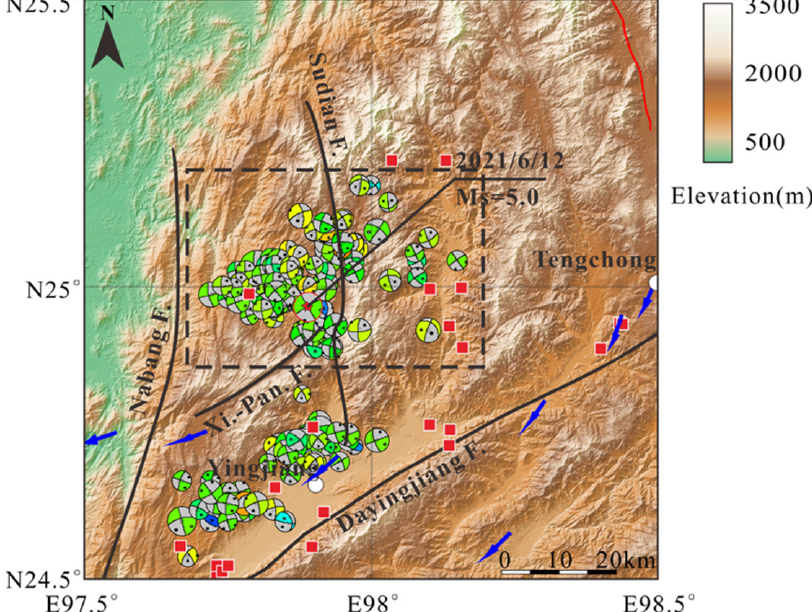
Figure 2. Distribution of the moment tensor solution used [31] shown by the beachballs in the study area. The dashed box shows the 187 selected focal mechanisms. The size of the sphere represents the magnitude of the earthquake. The remaining symbols are represented as shown in Figure 1.